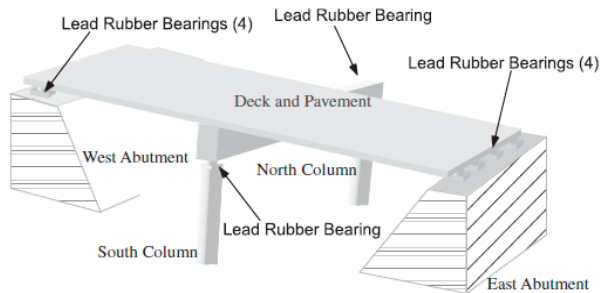
Figure 2. Schematic picture of the benchmark bridge [26].